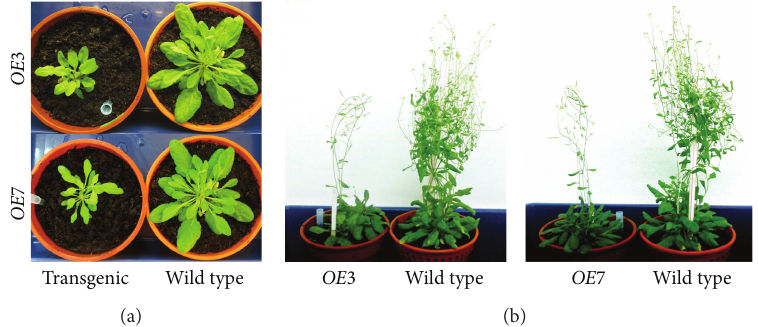
Figure 7: Comparison of the phenotypes of the transgenic A. thaliana and wild type A. thaliana . (a) Plants (2-month-old) were grown on soil for 1 month. Upper panel: OE 3 transgenic plant and wild type plant. Lower panel: OE 7 transgenic plant and wild type plant. (b) Two 4-month-old OE 3 and OE 7 T 2 plants compared with a 3-month-old wild type